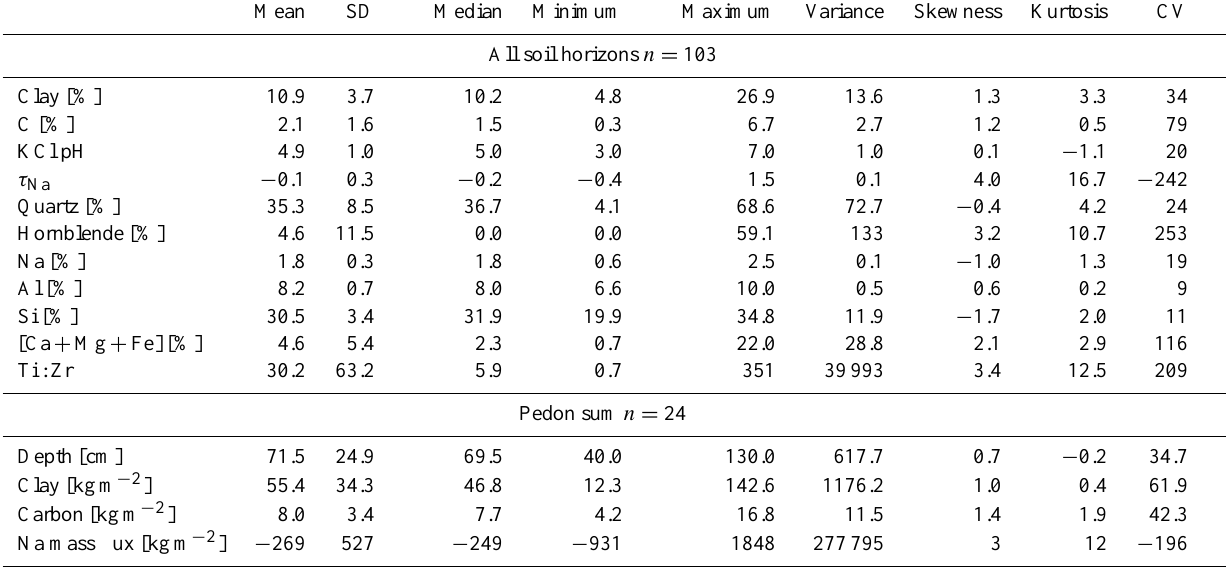
Table 1. Summary statistics of soil variables.